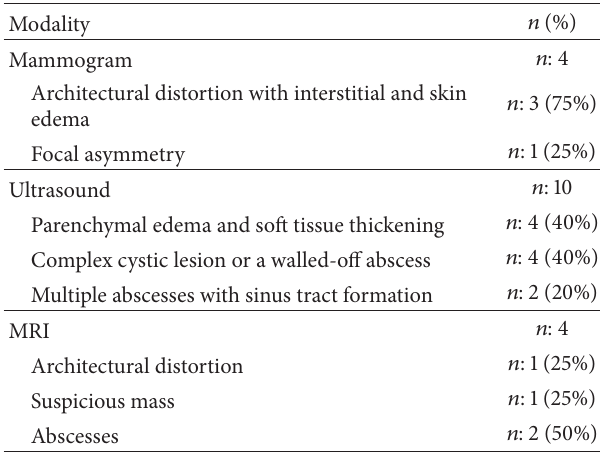
Figure 6: Granulomatous mastitis left breast. T1 axial postgadolin- ium MRI demonstrating retroareolar enhancing abnormality with periareolar skin thickening. It cannot be distinguished from a malignancy based on these imaging findings. Table 1: Imaging appearances of granulomatous mastitis on presen-